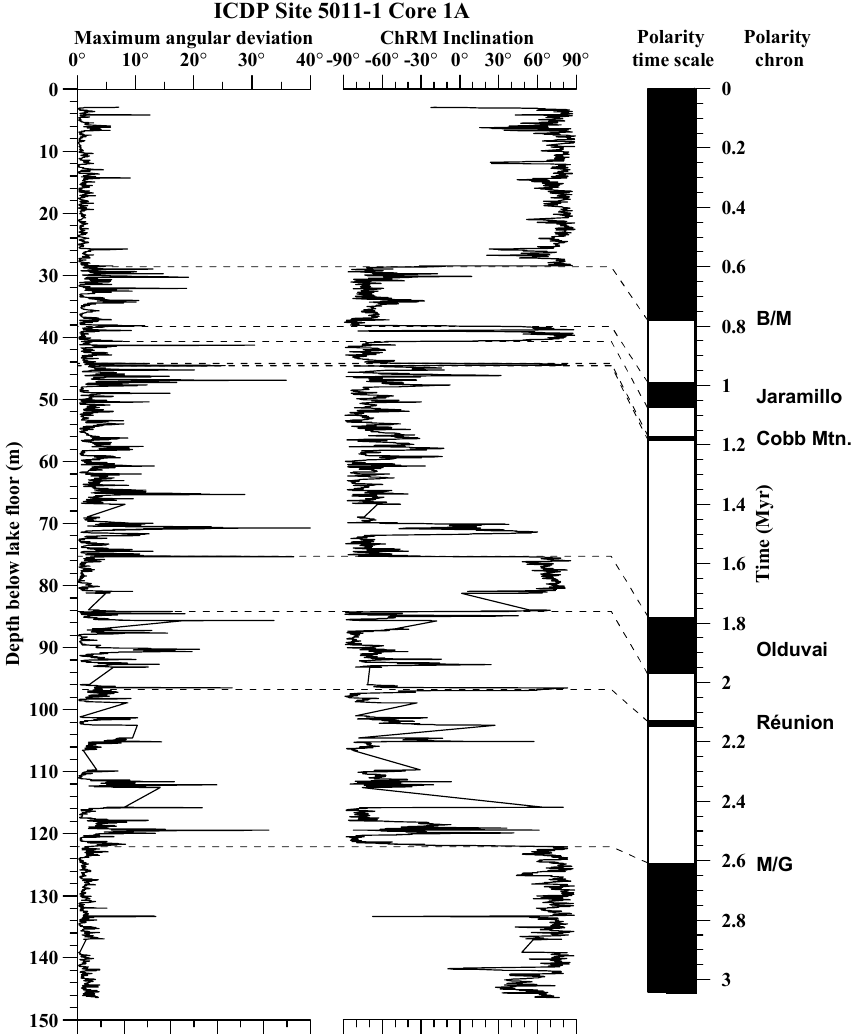
Fig. 5. Down-core variations in the inclinations of the characteristic remanent magnetization (ChRM) and maximum angular deviation (MAD) from core 1A. Dashed lines denote correlation of the ChRM inclination with the polarity timescale.